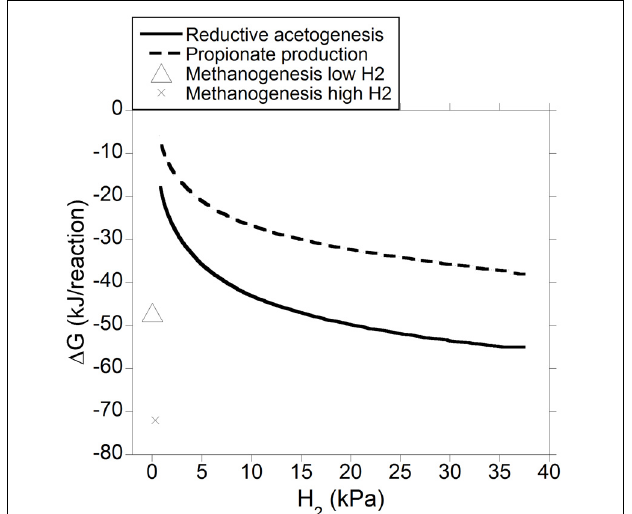
FIGURE 5 | Response in heat of combustion in VFA to H 2 incorporation into reductive acetogenesis or additional propionate formation. Corresponding fermentation with CH 4 as main electron sink is provided as reference.